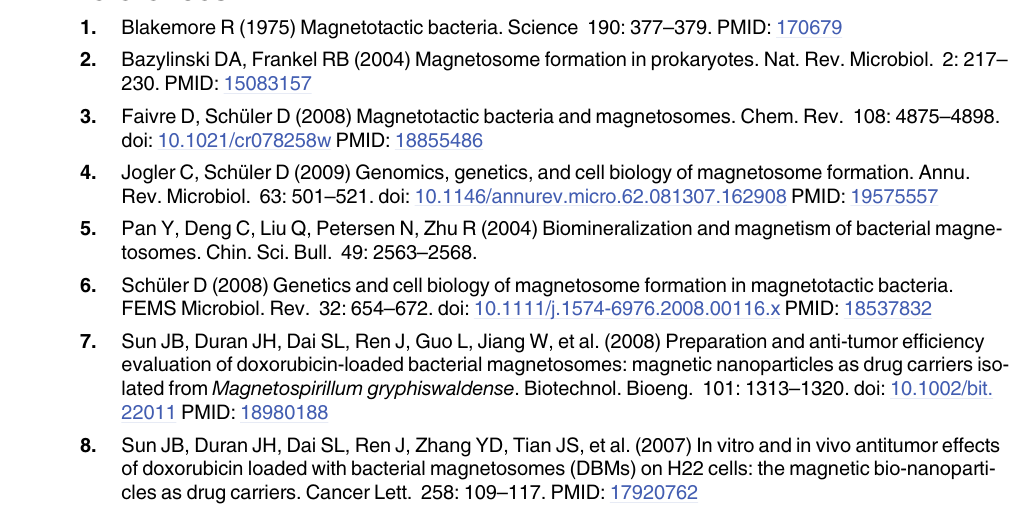
S2 Fig. Distribution of the size of magnetosomes in each cell grown in the culture medium supplemented with PEG200. The histograms represent the size distributions of magneto- somes in the absence (gray bars) and presence (solid bars) of PEG200. S3 Fig. Mass magnetization of magnetosomes synthesized in M . magnetotacticum MS-1 cultivated in the culture medium in the absence (black circles) and presence (white circles) of PEG200. S1 Table. Effect of several substances added to the culture medium on the growth of M . magnetotacticum MS-1 and the formation of